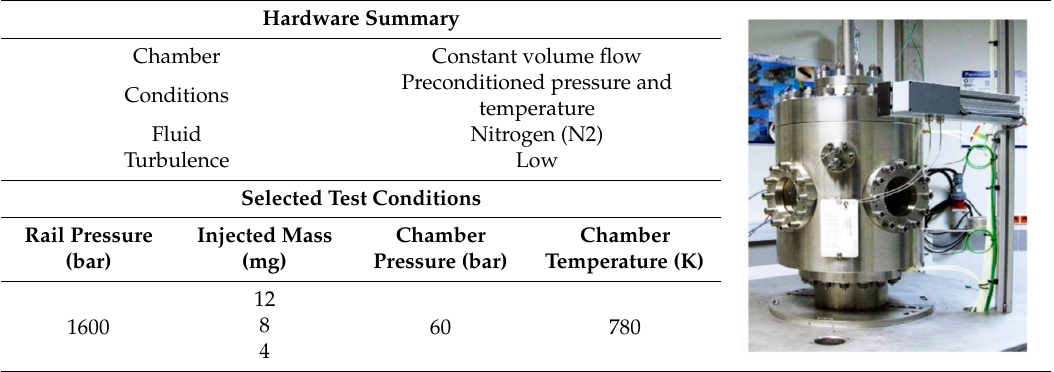
Table 1. Hardware summary and selected test cases for validation of the injection modeling. The image on the right shows the measurement equipment.